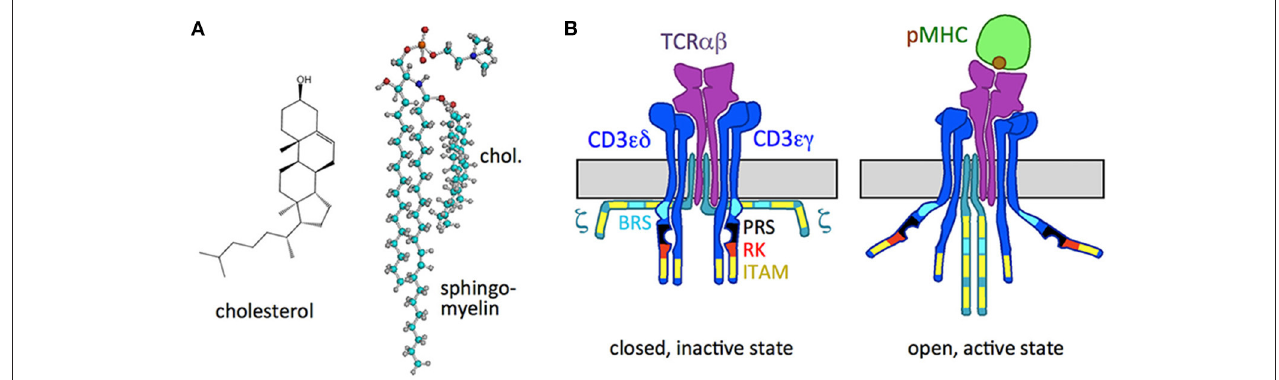
FIGURE 1 | Cholesterol and the TCR. (A) Structure of cholesterol and the cholesterol sphingomyelin pair. (B) Schematic of the resting, inactive TCR, in which the cytoplasmic signaling motifs of the CD3 and ζ subunits are not accessible (right), and of the active TCR with the pMHC ligand bound (left), in which the motifs are exposed. The ITAM, BRS, PRS, and RK motifs are